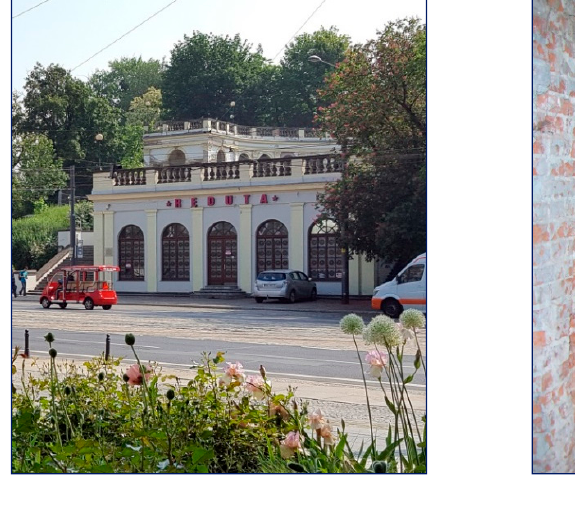
Figure 3. View of the colonnade building from the outside ( a ) and underground ( b ).